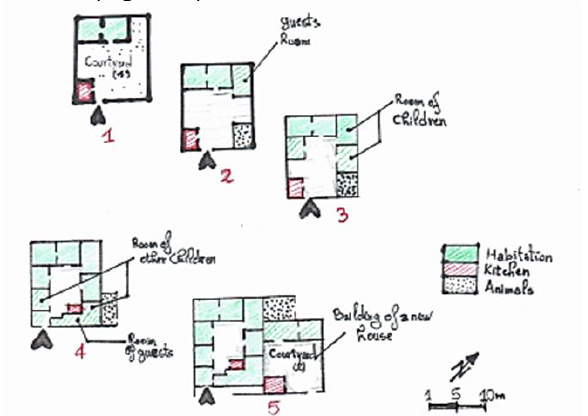
Figure 5. Evolution of a traditional house according to the Structure of Berber family (Authors developed from analysis and Marc Cote studies).